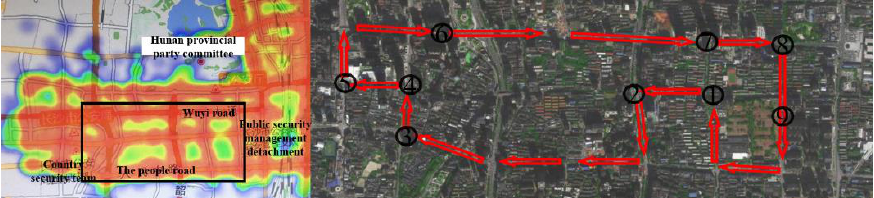
Figure 1. Introduction to the principle of the Tobii Pro Glasses and preprocessing of video data.